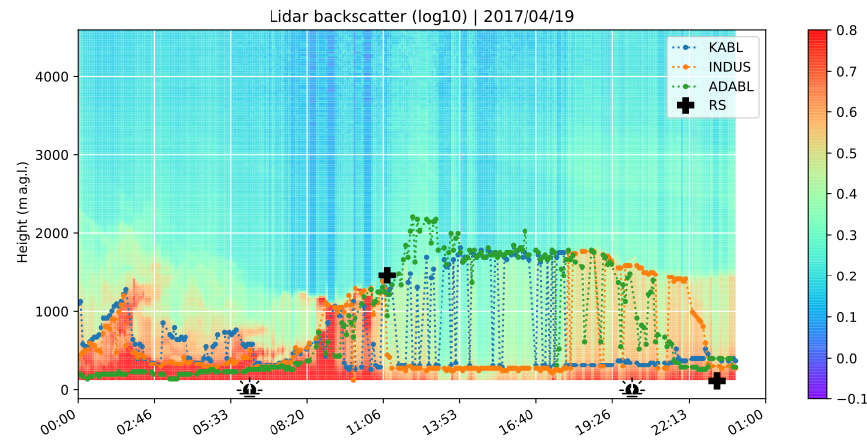
Figure 11. Case study: BLH estimates using different methods on 19 April 2017, at the Trappes site. Superimposed on the lidar range- corrected signal are BLH estimates from KABL (dotted blue line), the manufacturer’s algorithm (denoted INDUS, dotted orange line), and ADABL (dotted green line). The two crosses at 11:15 and 23:15UTC indicate the radiosonde estimates for that day, and the two icons at 05:50 and 19:49UTC represent the time of sunrise and sunset, respectively.